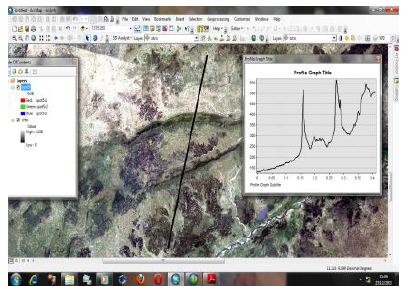
Figure 7. Topographic profile taken around